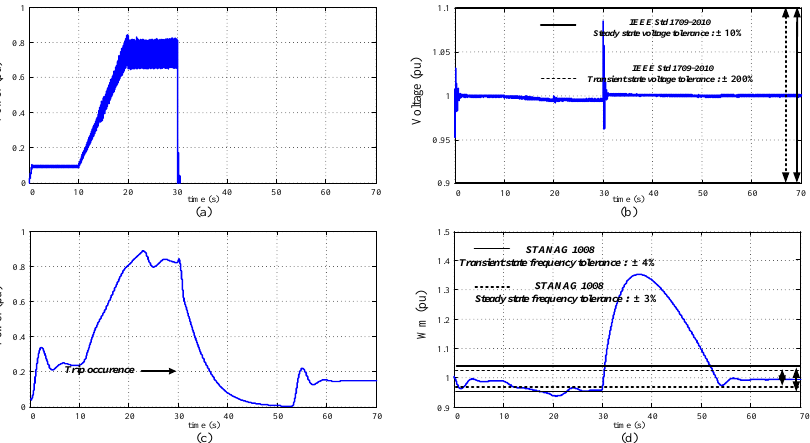
Figure 10. Simulation results of the full propulsion load rejection (without the energy storage system): ( a ) Output power of the propulsion motor; ( b ) Main DC bus voltage; ( c ) Output power of the steam turbine; ( d ) Frequency of the generator.